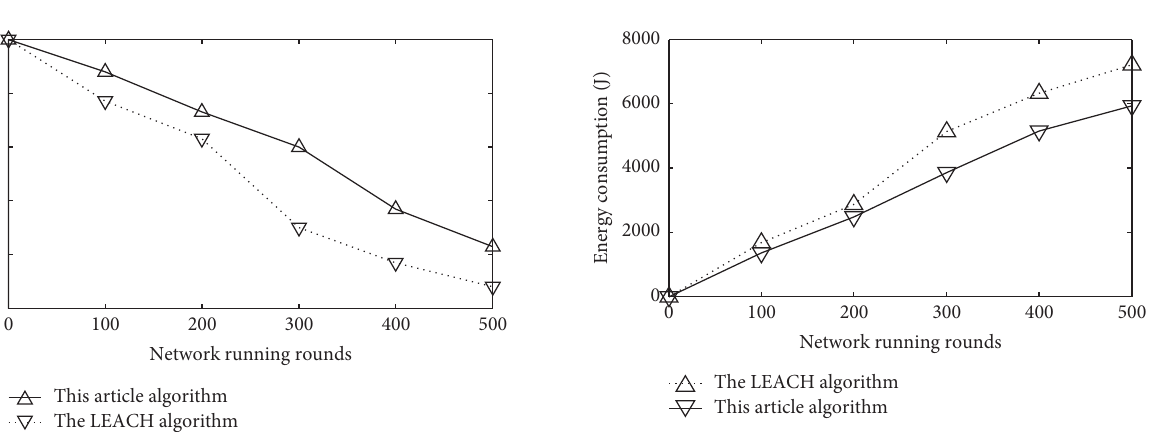
Figure 5: Network coverage rate comparison in this article’s al- gorithm and the LEACH algorithm under different network running rounds.